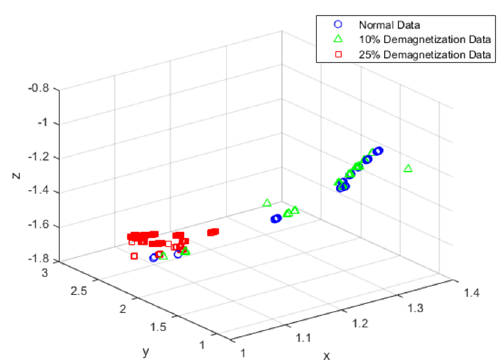
Figure 7. Three-dimensional vectors of test data. The distribution of three test PMSMs: blue circles represent data for the normal PMSM, green triangles represent data for the PMSM with 10% demagnetization fault, and red squares represent data for PMSM with 25% demagnetization fault